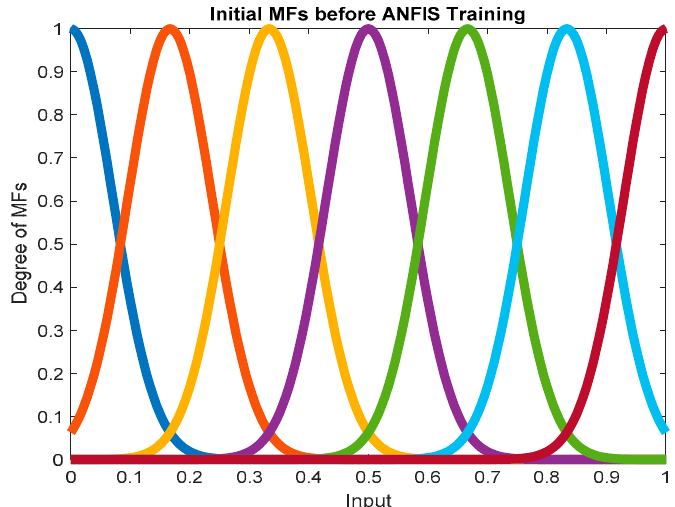
Figure 13. Initial MFs before ANFIS training. Layer4: Each and every node in this layer is an adaptive node, and the output of this node comprises normalized firing strength (W l ) and consequent parameter (y i